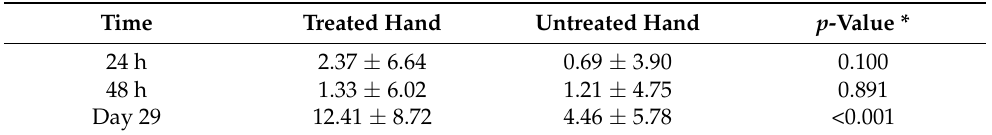
Table 2. Bilateral differences in changes from baseline for skin capacitance after a single application of ND-HC (initial 48 h) and after a 4-week application period (at least four times daily). Time Treated Hand Untreated Hand p -Value * 24 h